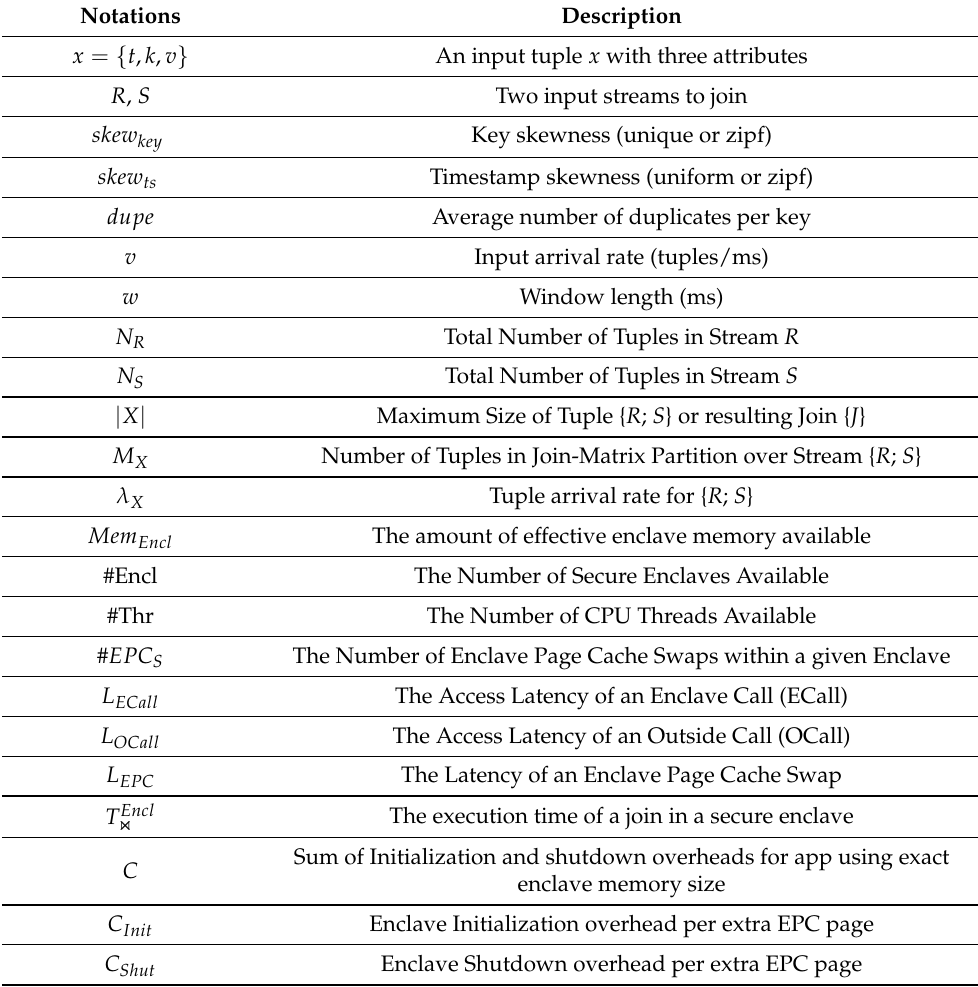
Table 1. Notations used in this